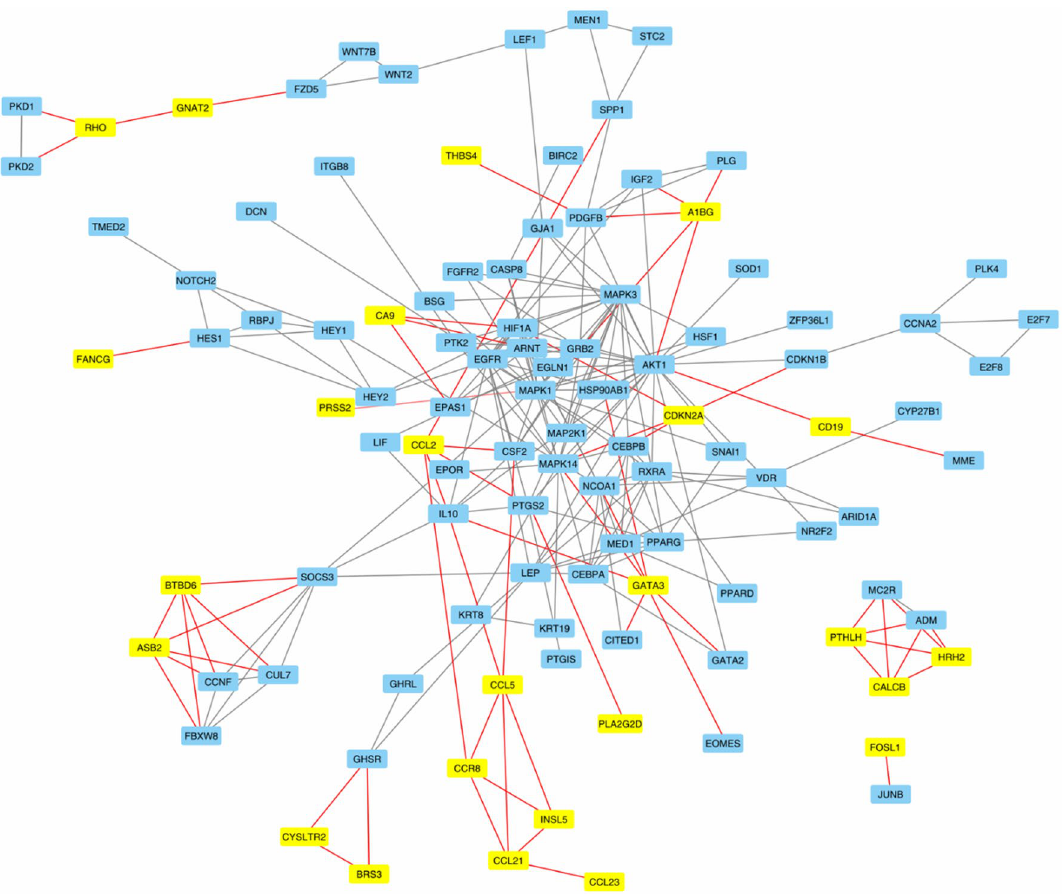
Figure 2. Functional relationships between the products of genes hypermethylated in chorionic trophoblasts of embryos with trisomy 16 (highlighted in yellow) and the products of genes involved in the development of the placenta (placental development, GO: 0001890) (highlighted in blue) (STRING database, score > 0.90). The connections of the products of the hypermethylated genes with the proteins involved in the development of the placenta are highlighted in